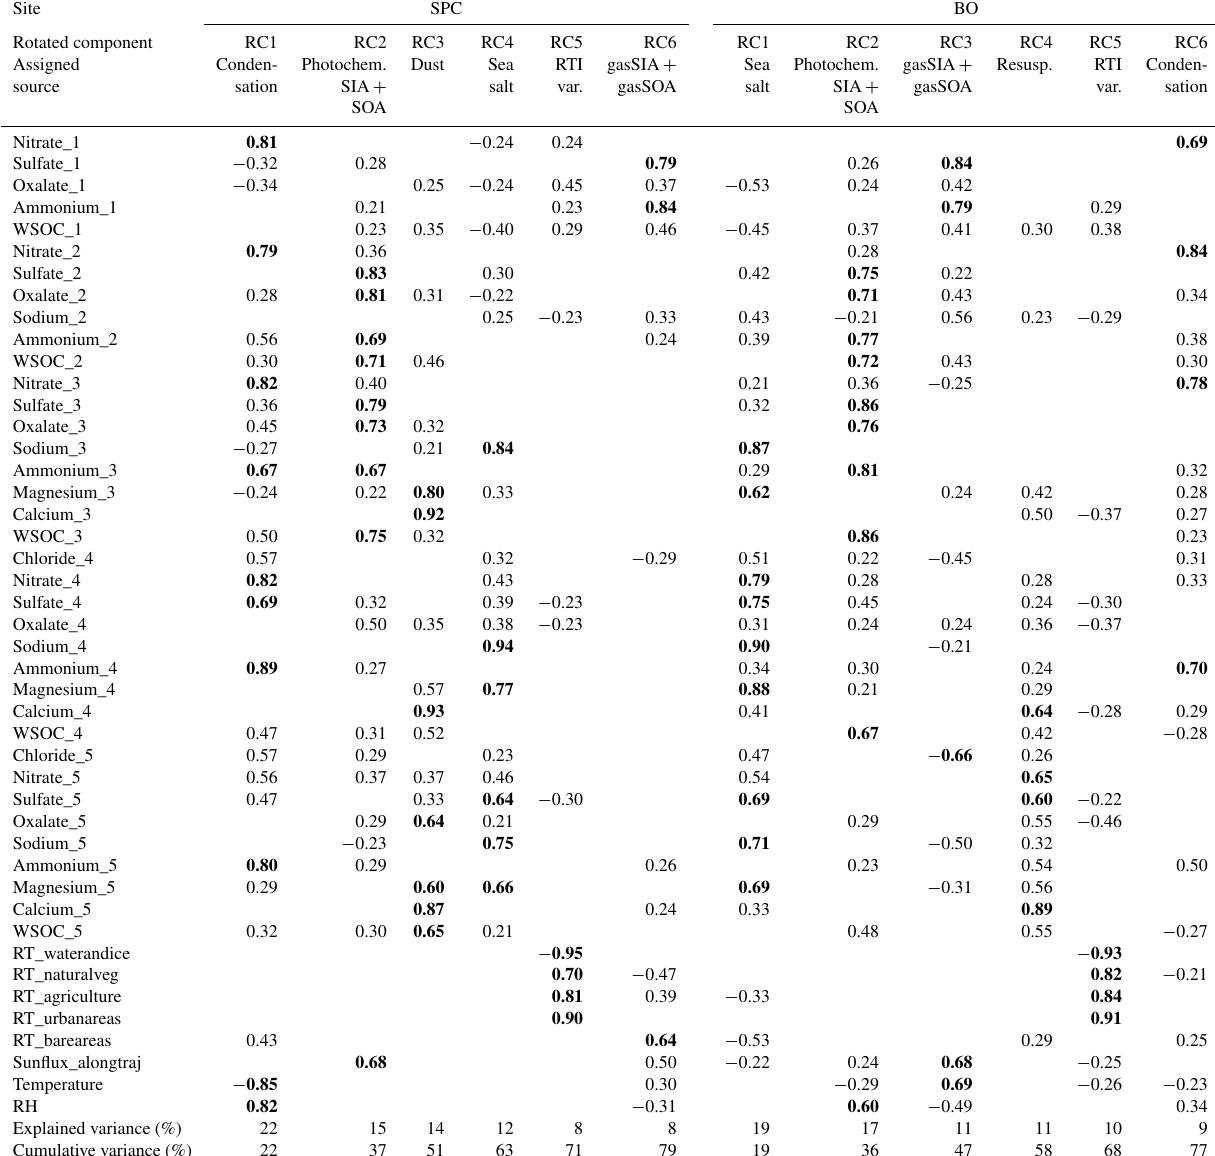
Table 2. Factor loadings of PCA after Varimax rotation. Only absolute values larger than 0.2 are shown. Absolute values larger than 0.60 are considered significant and printed in bold. The number beside each chemical species in the first column indicates the impactor stage. Site